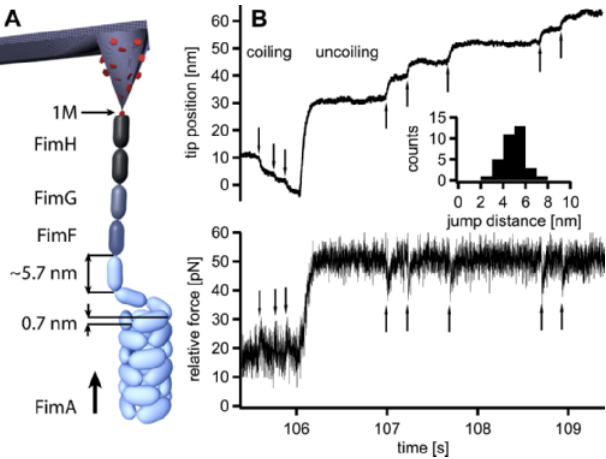
Figure 3. Discrete Coiling and Uncoiling Events of a Single Fimbria (A) Cartoon showing the structure of fimbriae attached to an AFM tip. The lectin domain of FimH binds specifically to mannose on the AFM tip. The fimbrial tip consists of the FimH adhesin (lectin plus pilin domain) and the FimG and FimF monomers. Below them is the 7-nm-diameter shaft (also called pilus, fimbria) made from helically coiled FimA subunits. FimA subunits contribute 0.7 nm to the length of the helical shaft [9]. By homology to the pilin domain of FimH, the length of the FimA subunit is approximately 5.7 nm. The steps measured in (B) are in good agreement with the 5-nm extension expected from (A). (B) Discrete elongation and contraction events are seen when a single fimbria is pulled at constant force just below and above the force where coiling and uncoiling rates have equal probability ( f bal ). The bottom trace shows that the force is temporarily lowered whenever a length increase is observed. The histogram shows the frequency of both coiling and uncoiling events combined with a peak at 5.0 6 0.3 nm. The frequency of these single-step events increases when the applied force approaches f bal, as expected from Equation 3. The spring constant of the cantilever used in this experiment was 6.5 pN/nm. The individual events in the histogram were obtained from four different bacteria. DOI: